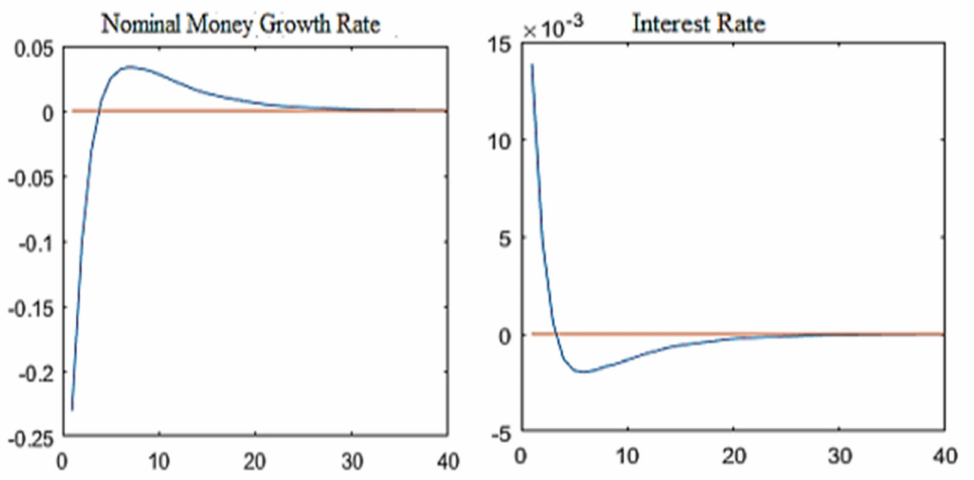
Figure 3. Comparisons of impulse responses between price and quantitative monetary policy (basic model; e-money facilitates